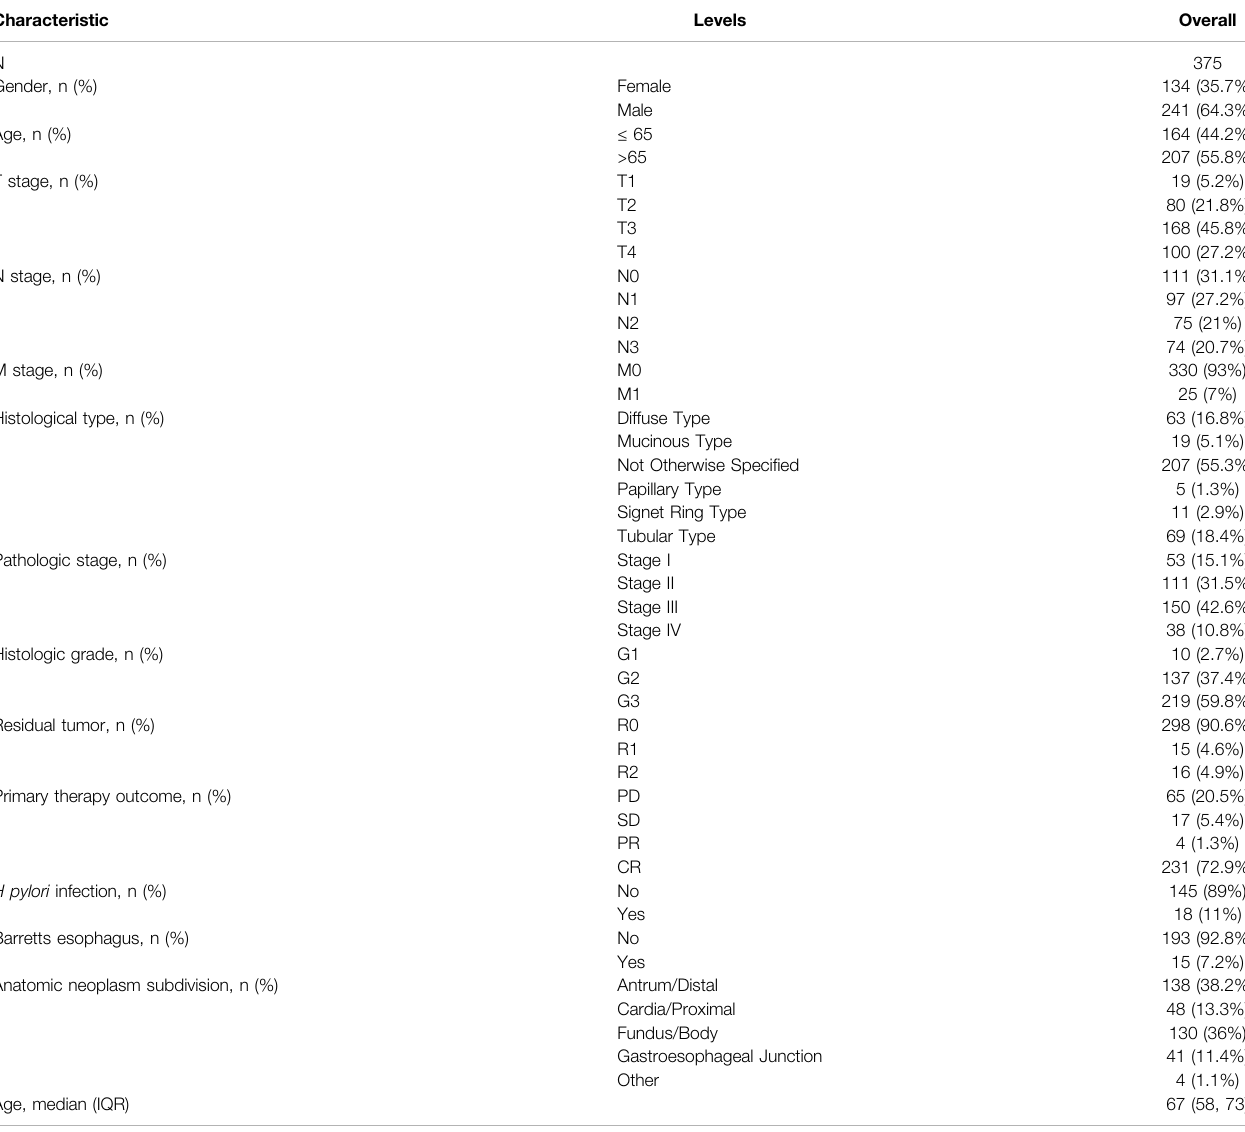
TABLE 1 | The clinical characteristic of Gastric